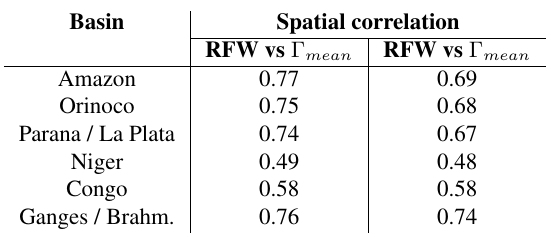
Figure 4. Comparison of CYGNSS mean reflectivity with Tootchi’s inundation maps and CCI Land Cover classification. (a1) , (a2) , (a3) show respectively an average of Γ std over the year, the maximal percentage of floods in each pixel, and the dominant LC type in the pixel over South America. Orinoco, Amazon and La Plata floodplains are highly visible in blue. (b1) , (b2) and (b3) show the same variables plotted over the Sahel and Congo region, including the Niger and a part of the Congo basins. (c1) , (c2) and (c3) show the same variables over the eastern part of India, where the seasonal floods and the irrigation of croplands in the Ganges-Brahmaputra basin is frequent. For more information about the CCI LC classes, readers are invited to visit the CCI webpage Table 1. Spatial correlation coefficients computed between Tootchi’s RFW map and CYGNSS Γ mean and Γ std for the main river basins visible in Figure